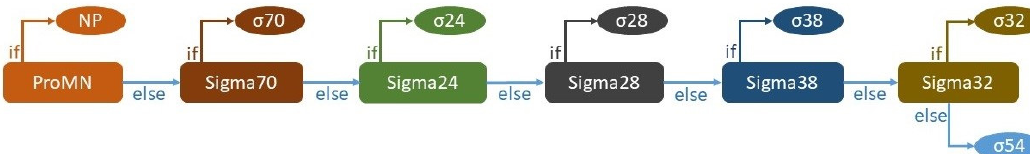
Figure 2. Model overview of pcPromoter-CNN. Table 2. Cascade binary classifiers.